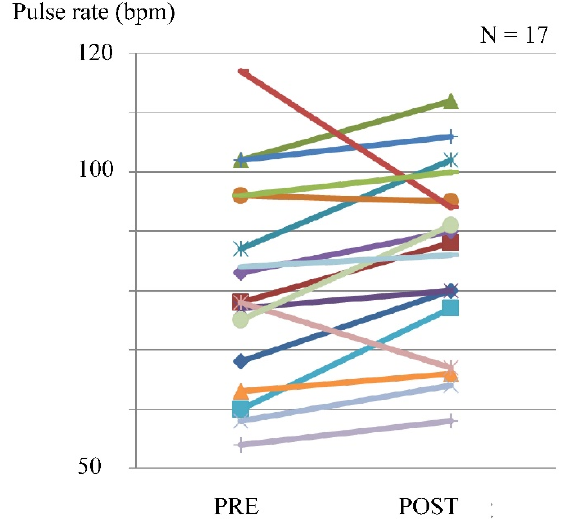
Figure 4. Pulse rate before and after exercise using the leg exercise apparatus. In some cases, a maximum reduction of 2% in SpO 2 was observed, but there were no complaints of dyspnea (Figure 5).